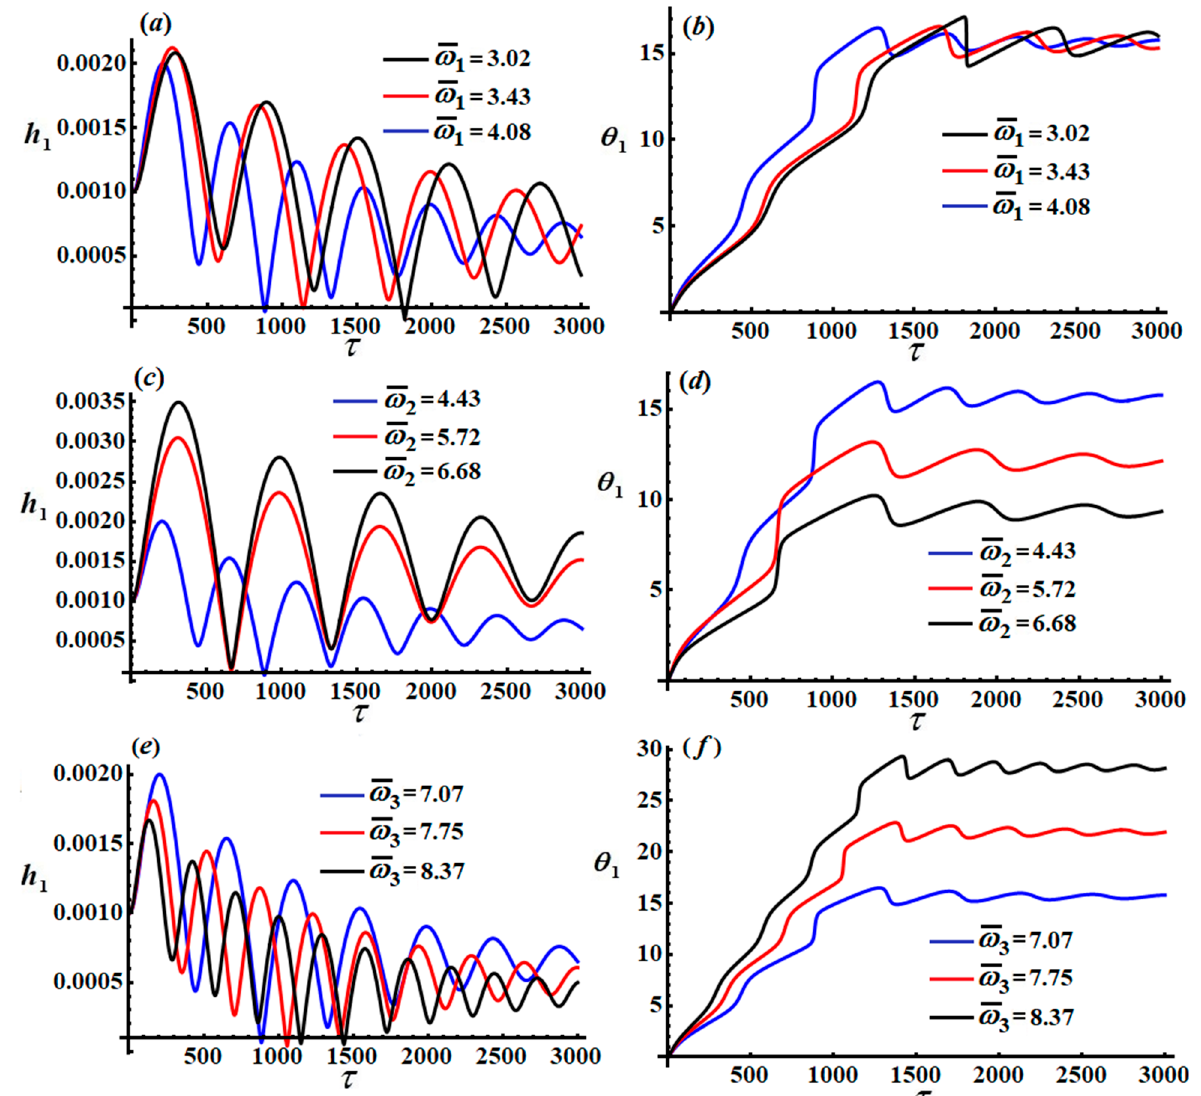
= ( 3.02,3.43,4.08 ) , 1 and modified phase θ 1 : ( a , b ) at ω 1